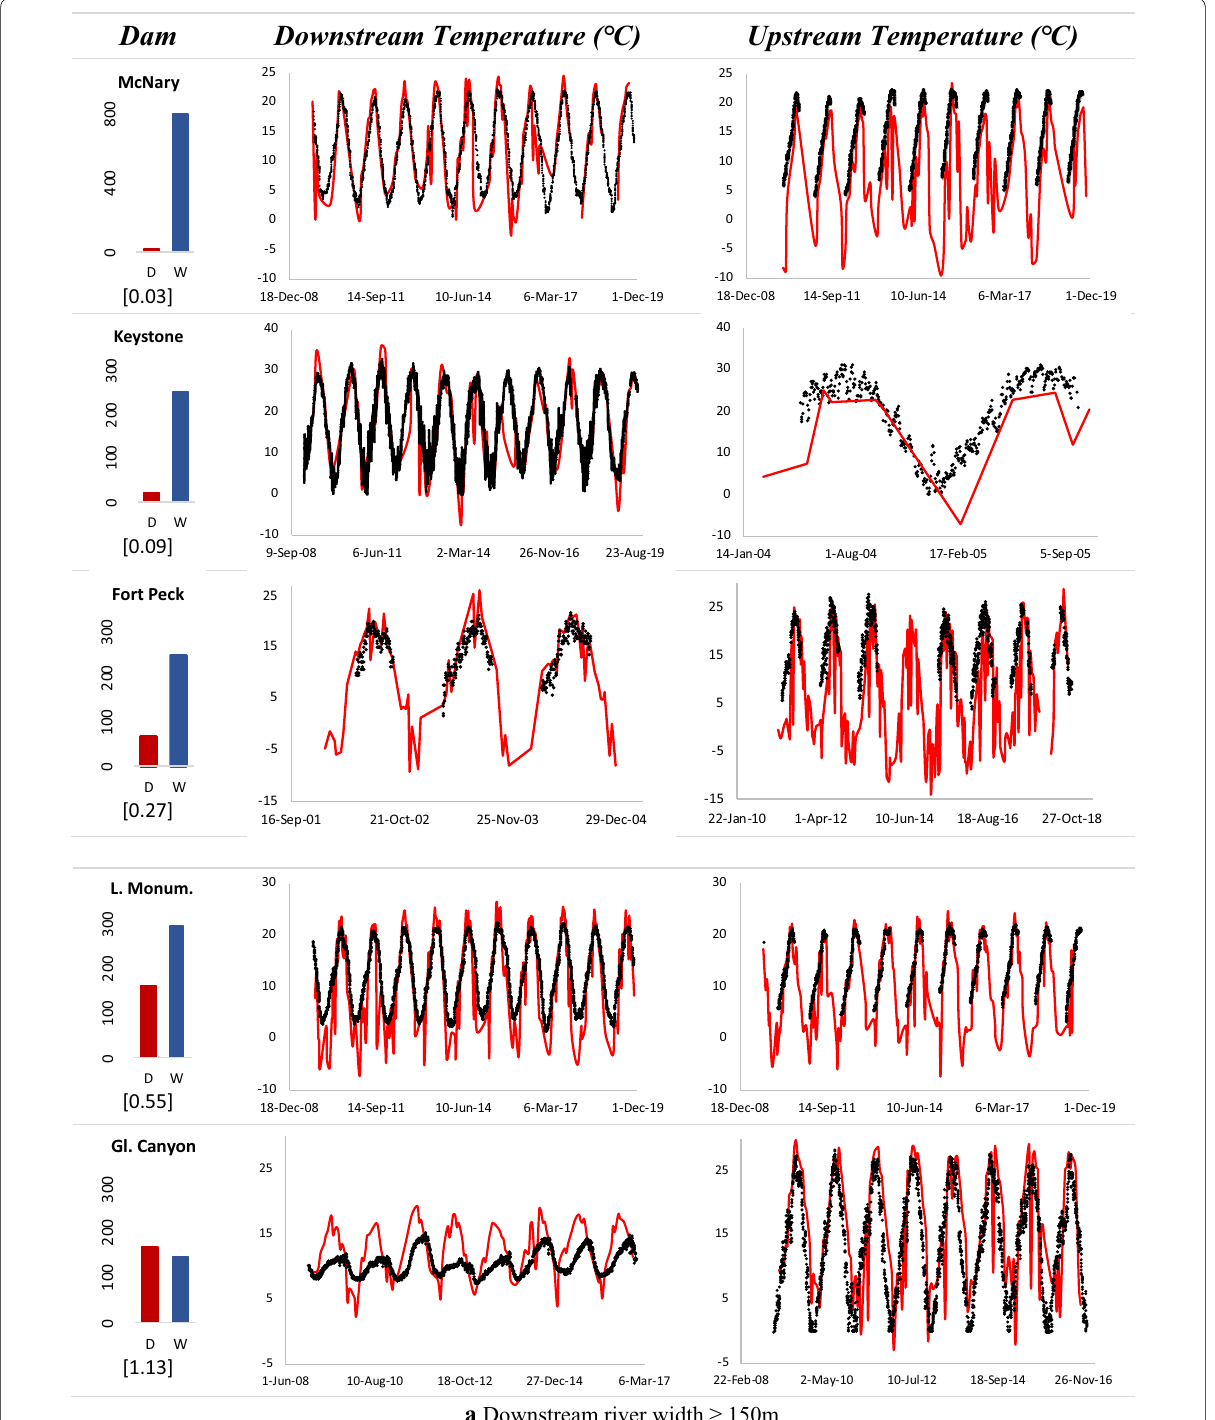
Fig. 8 Time-series of remote sensing-based temperatures (red), compared with USGS in situ measurements (black) upstream and downstream of dams with a W 150 m, and b W < 150 m. The average reservoir depth ( D ) and downstream river width ( W ) in meters as well as D/W ratio (in square ≥ brackets) for each dam are shown